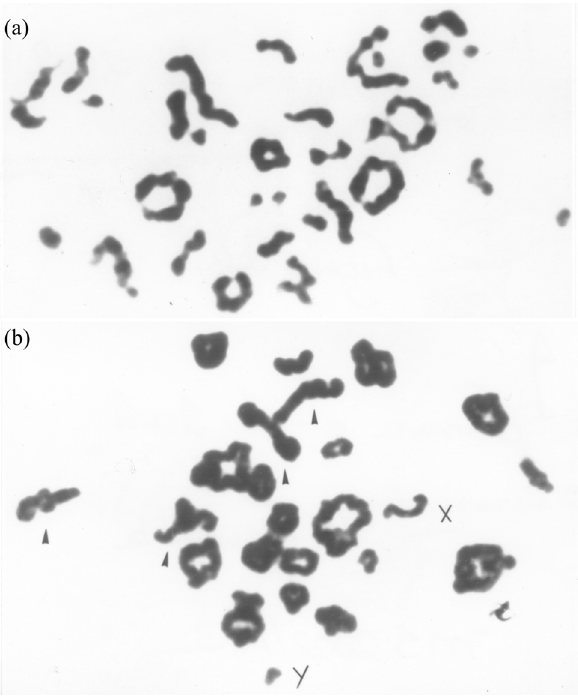
Figure 1 - (a) Metaphase with complete desynapsis; (b) Metaphase with individual desynapsis of autosomal (arrows) and XY